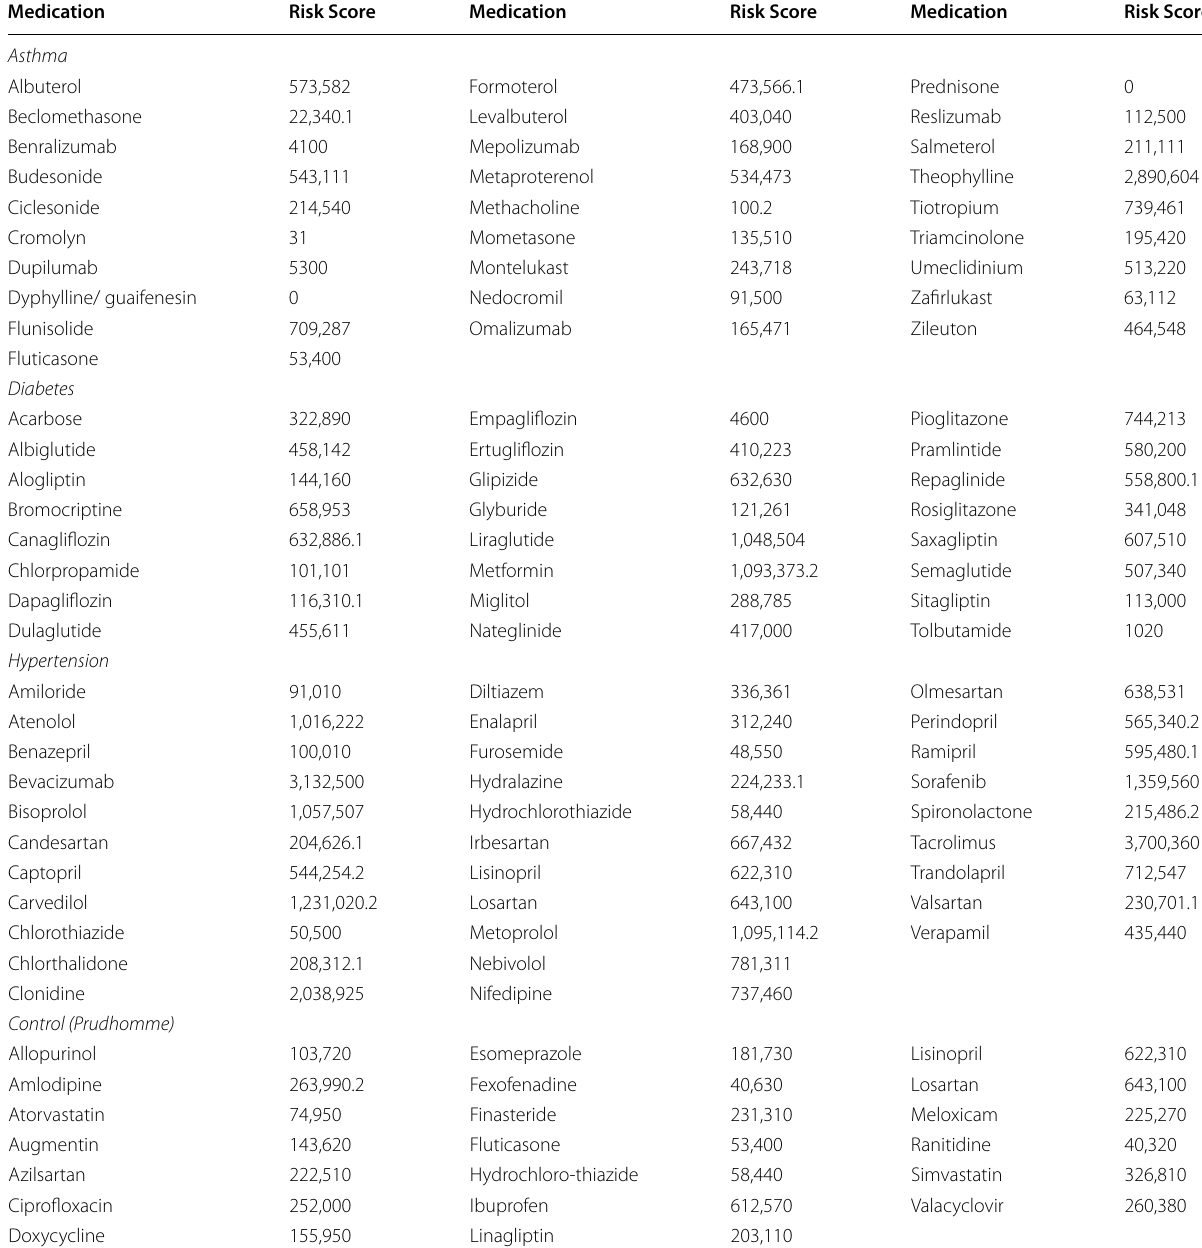
Table 1 Medications, risk scores and primary clinical condition. Medications contained in the Prudhomme study which are prescribed for one of the three conditions are included in the PA list